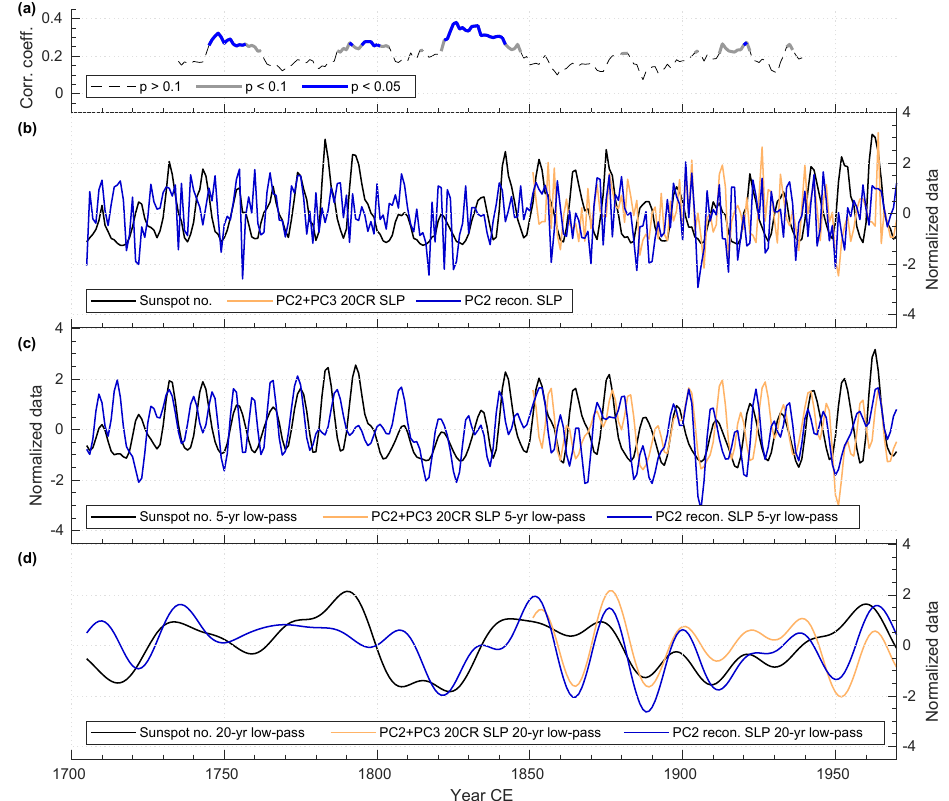
Figure 7. Reconstructed PC2 of SLP plotted with the 5-year lagged sunspot number. (a) Moving 61-point correlation between reconstructed PC2 of SLP and sunspot number shifted for a 5-year time lag. (b) Time series of sunspot number shifted for a 5-year time lag, PC2 + PC3 of 20CR SLP (see text and Table 4) and PC2 of reconstructed SLP. (c) Same as (b) , except filtered with a 5-year low-pass filter. (d) Same as (b) , except filtered with a 20-year low-pass